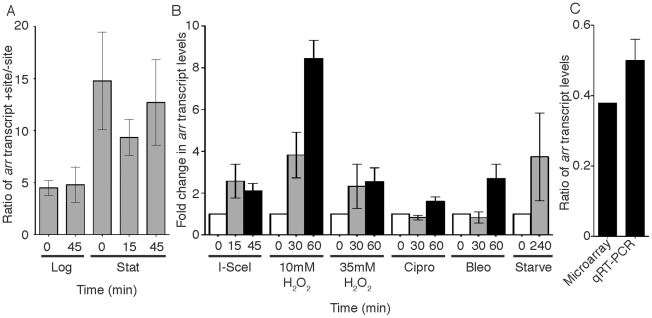

arr is transcriptionally upregulated in response to a range of stresses.All graphical data is represented as the mean ± SEM of biological triplicates. A. Mean ratios of arr transcript levels in site(+) versus site(−) cultures from microarray experiments. The time after ATc addition is indicated beneath the graphs for both log and stationary experiments. All p-values for arr transcript levels were <0.05 for the comparison of site(+) to site (−). B. Mean ratios of arr transcript levels in site(+) cultures following ATc addition (I-SceI bars) and wild-type M. smegmatis treated with hydrogen peroxide (H2O2), 10 µg/ml Ciprofloxacin (cipro), 10 µg/ml bleomycin (bleo), or starved in PBS +0.05% Tween 80 (starve), as compared to untreated cultures. Transcript levels were determined by qRT-PCR with primers specific for arr and normalized to sigA transcript levels. C. Mean ratios of arr transcript levels in M. smegmatis Tet-CarD cultures grown in the absence of ATc for 13 hours to deplete CarD versus levels in control cultures, as determined by either microarray (p-value<0.05) or qRT-PCR analysis.